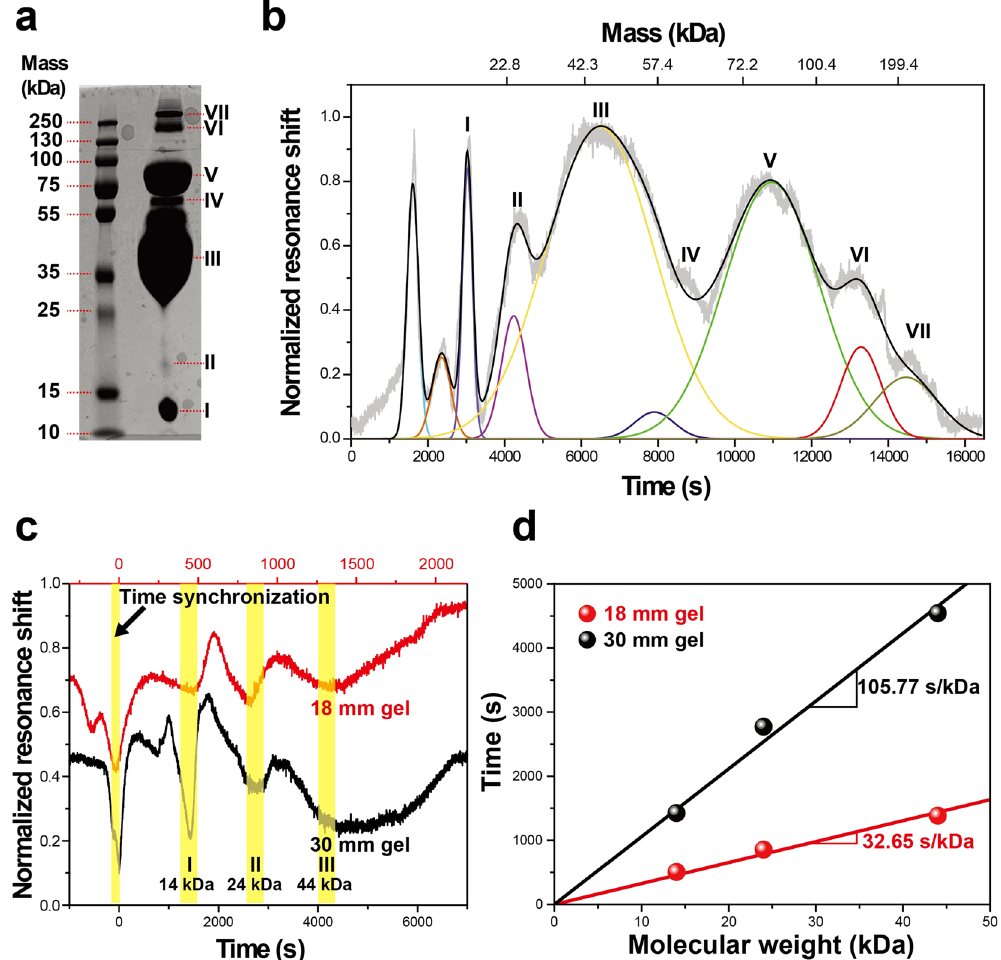
Figure 2. Comparison of PAGE and Time-of-flow mass spectrum of egg white proteins. ( a ) Polyacrylamide gel electrophoresis (PAGE) of egg white sample is shown along with the PAGE standard in the molecular weight range of 10–250 kDa. (b ) Time-of-flow mass spectrum of egg white. Peaks below certain area value have been neglected as noise. Mass scale on top is shown only for the region 14–250 kDa as only this mass range has been verified using PAGE. ( c ) Comparison between time-of-flow mass spectra and ( d ) rate of protein elution in two different gel lengths (18 and 30